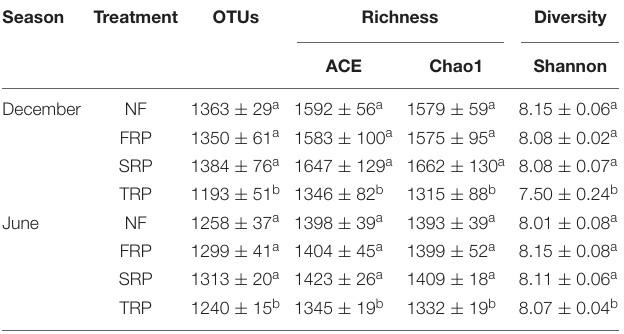
TABLE 2 | Soil bacterial alpha diversity indices in different generations of Chinese fir plantation (December and June) at the Xinkou Forest Farm, Fujian, China. Season Treatment OTUs